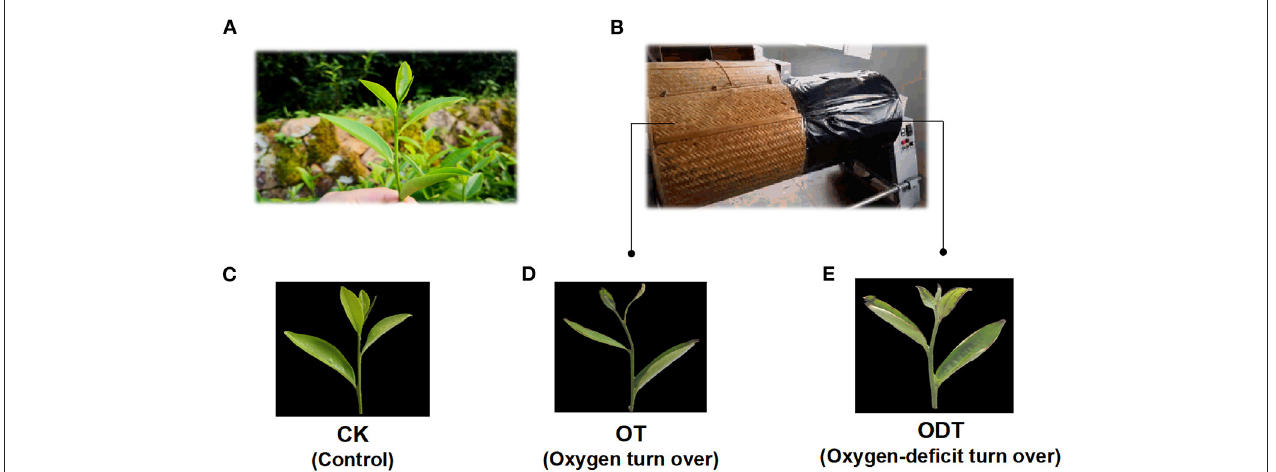
FIGURE 3 | Sampling schematic diagram of oxygen deficiency and normal turnover treatment. (A) Fresh leaves were sampled from a tea plant ( Camellia sinensis cv. Huangdan) in the tea garden. (B) In situ photographs were taken at the turnover test site. (C–E) Apparent imaging of control (CK), oxygen-turnover tea leaves (OT), and oxygen-deficit-turnover tea leaves